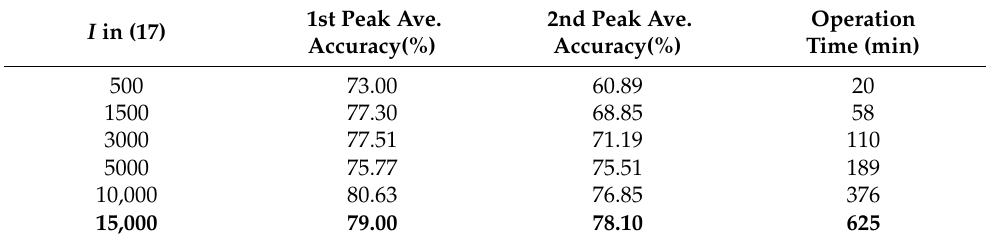
Figure 5. The relationship between the number of Monte Carlo cycles and forecast accuracy. Table 3. Average prediction accuracy under different Monte Carlo cycles. Table 3. Average prediction accuracy under different Monte Carlo cycles. 1st Peak Ave. I in (17)